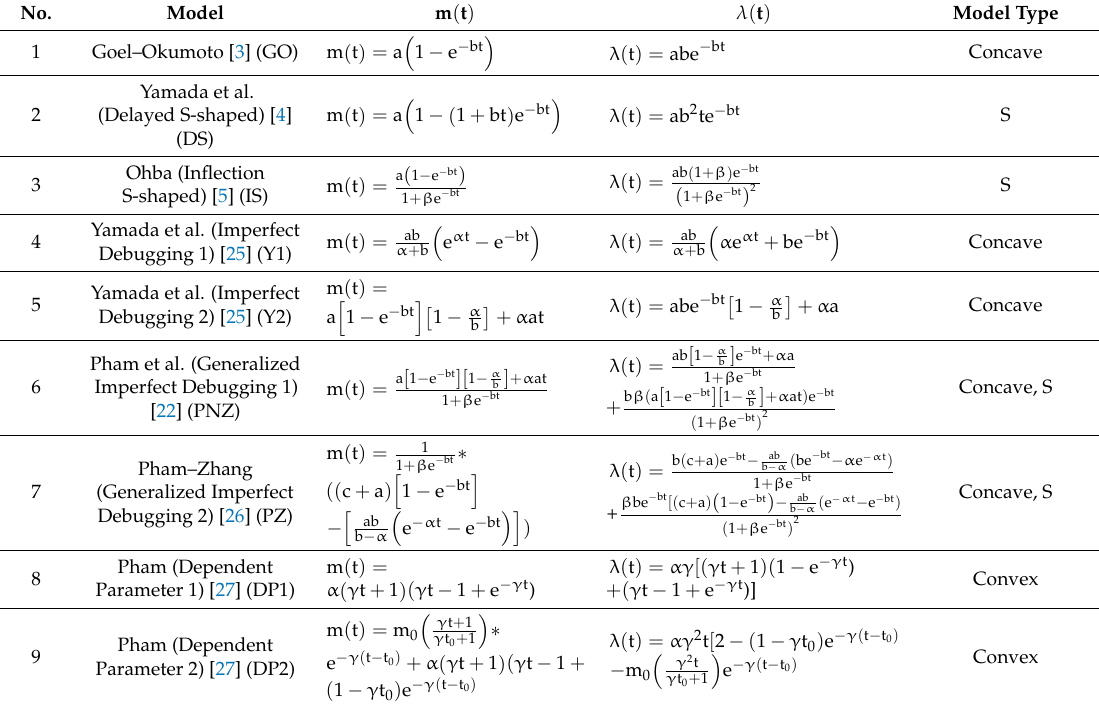
Table 1. Nonhomogeneous Poisson process (NHPP) software reliability models and their mean value functions and intensity